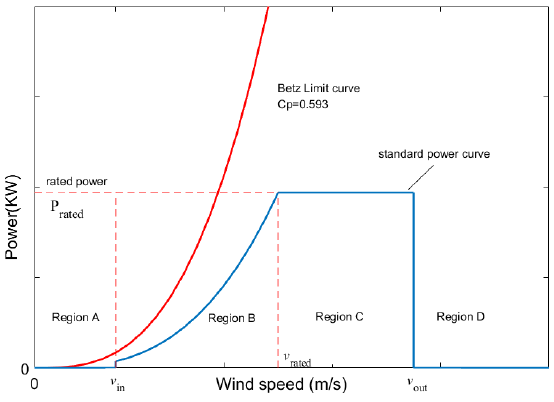
Figure 1. Power curve of a pitch-regulated wind turbine.